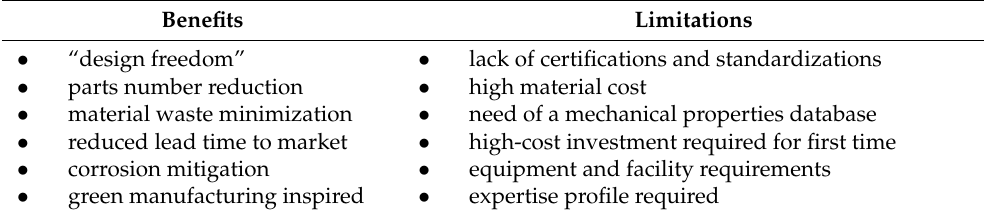
Table 1. Main features of AM in the aerospace